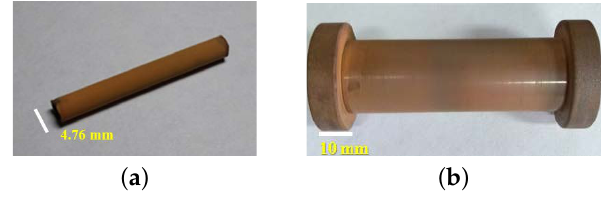
Figure 1. ( a ) Oxidized copper tube; and ( b ) oxidized copper